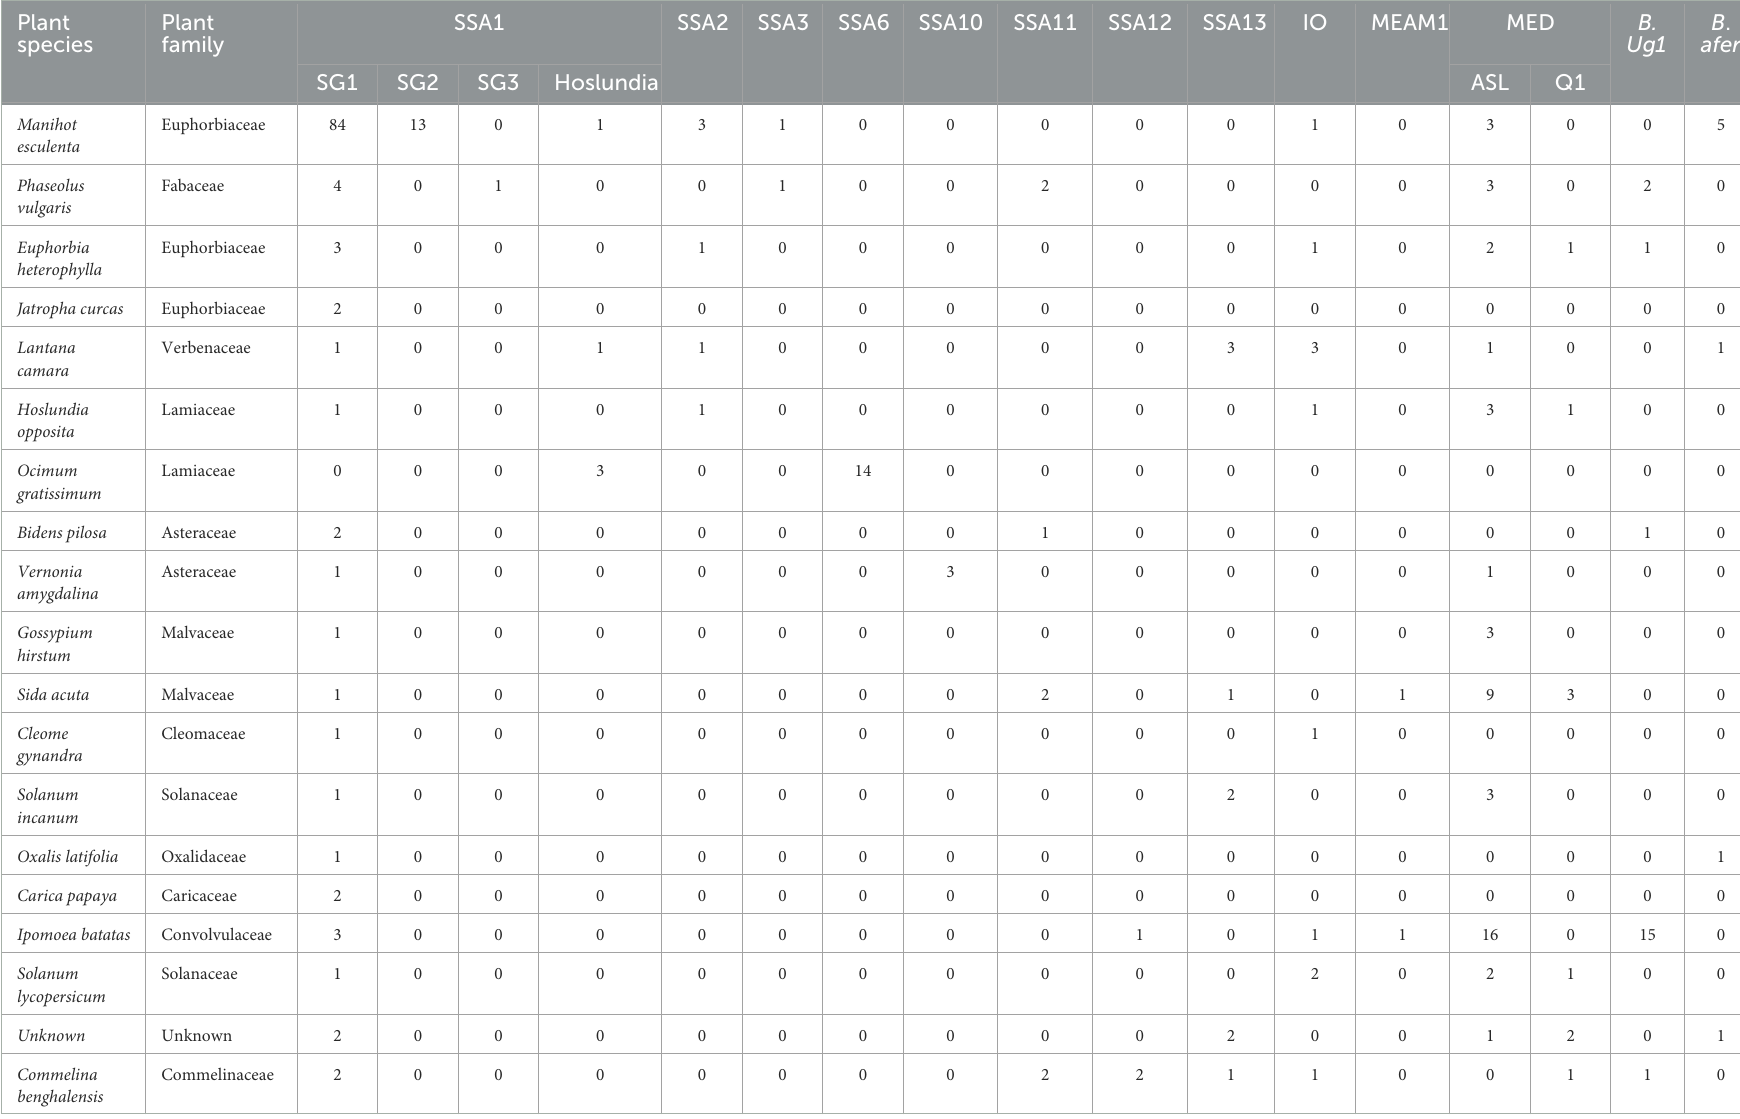
TABLE 1 Numbers of adult B. tabaci species and other whitefly species collected from cultivated and non-cultivated host-plants during May/August 2017 in Uganda. Plant